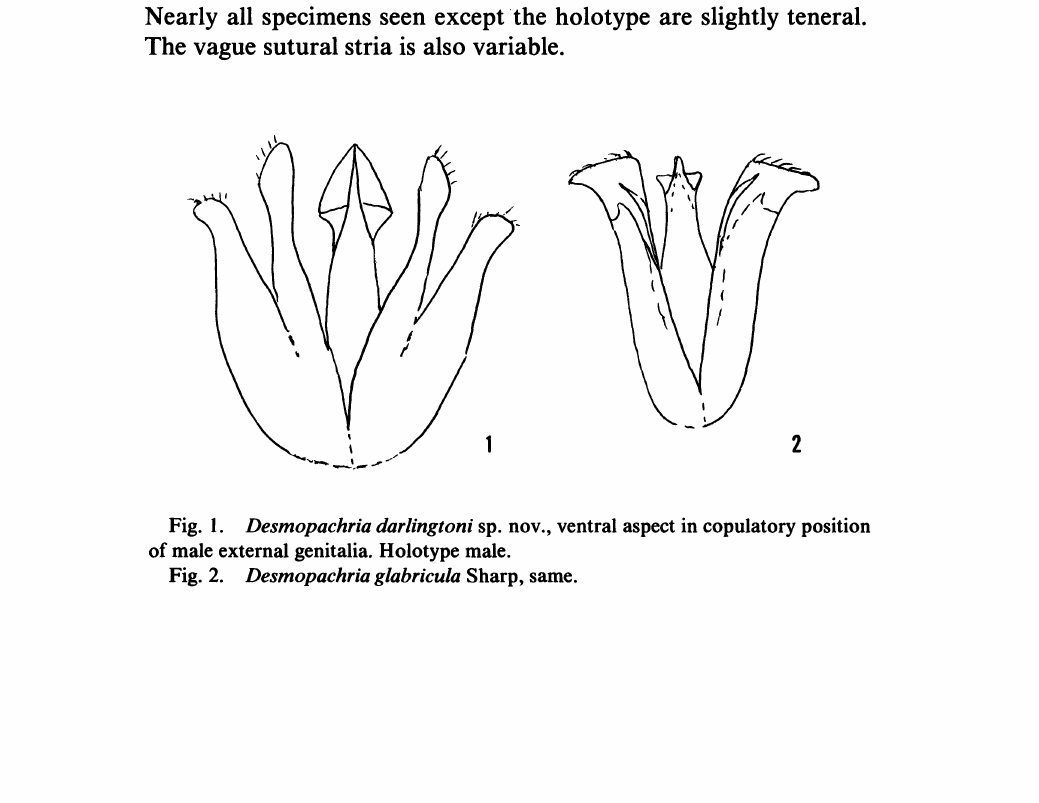
Fig. 1. Desmopachria darlingtoni sp. nov., ventral aspect in copulatory position of male external genitalia. Holotype male. Fig. 2. Desmopachria glabricula Sharp,